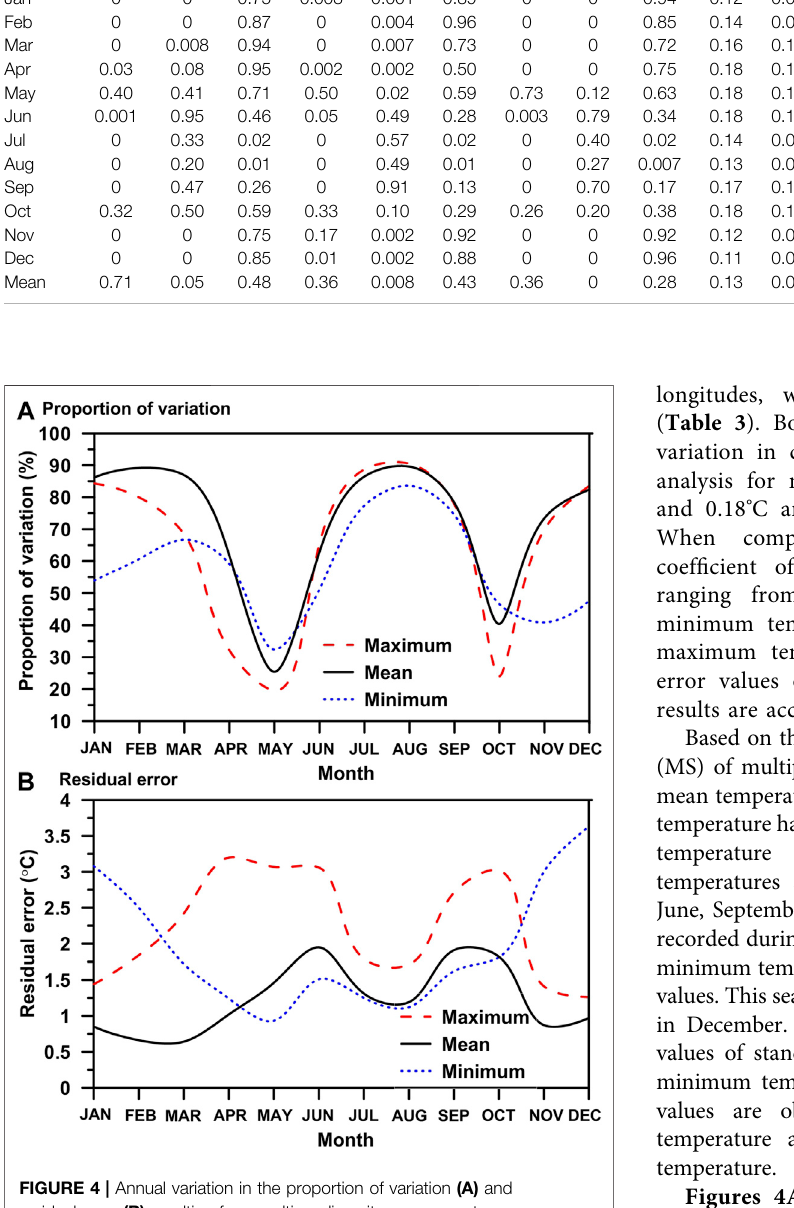
Frontiers in Earth Science |